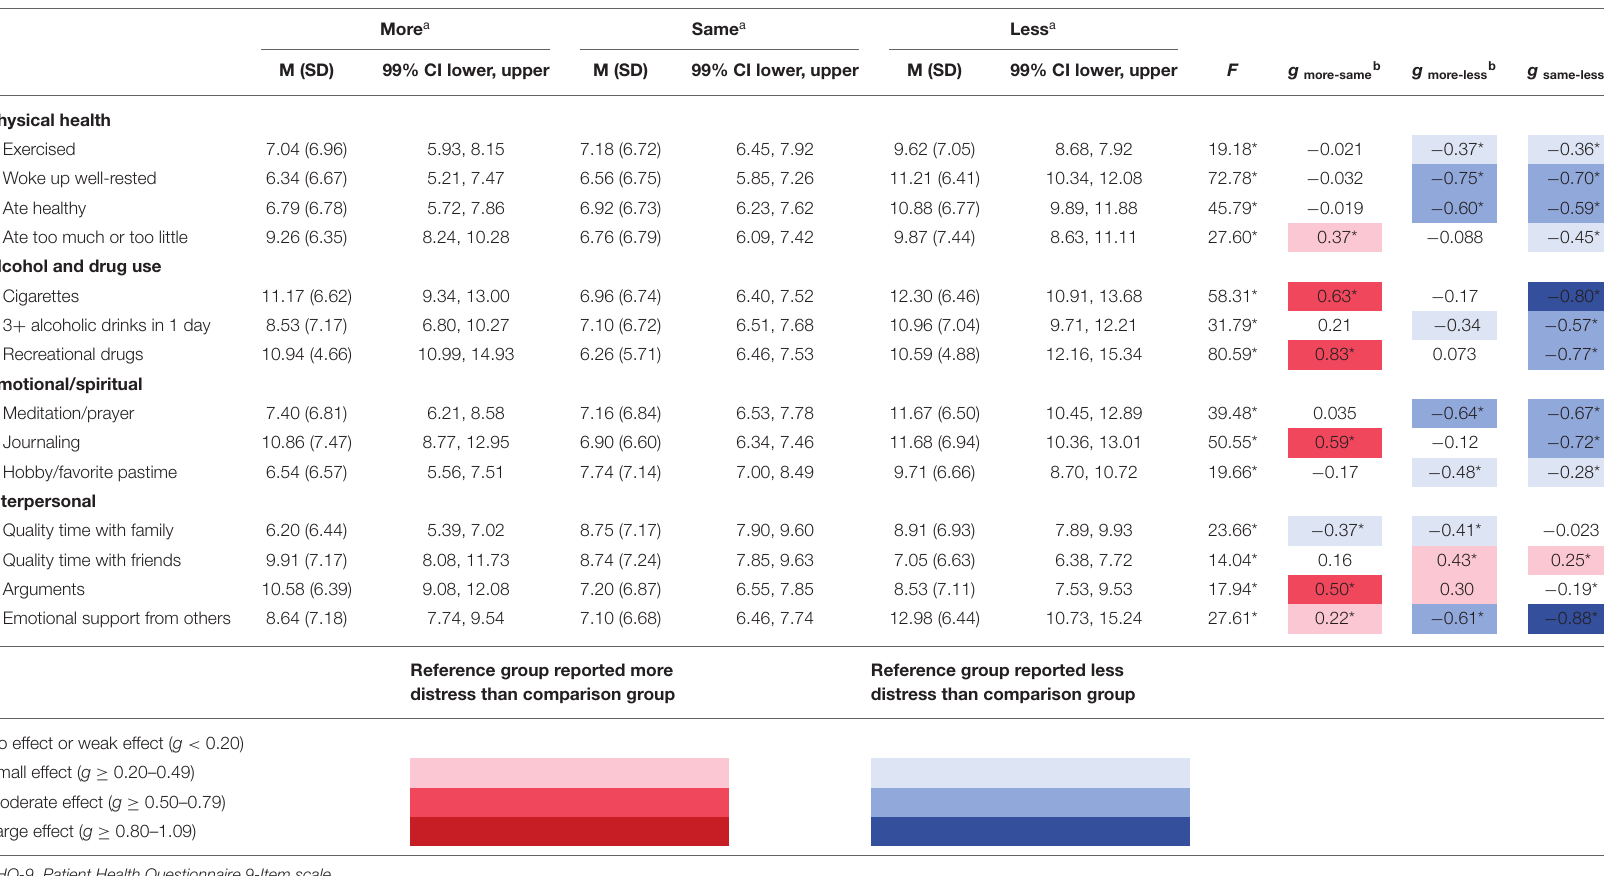
TABLE 4 | Associations between behaviors and depression